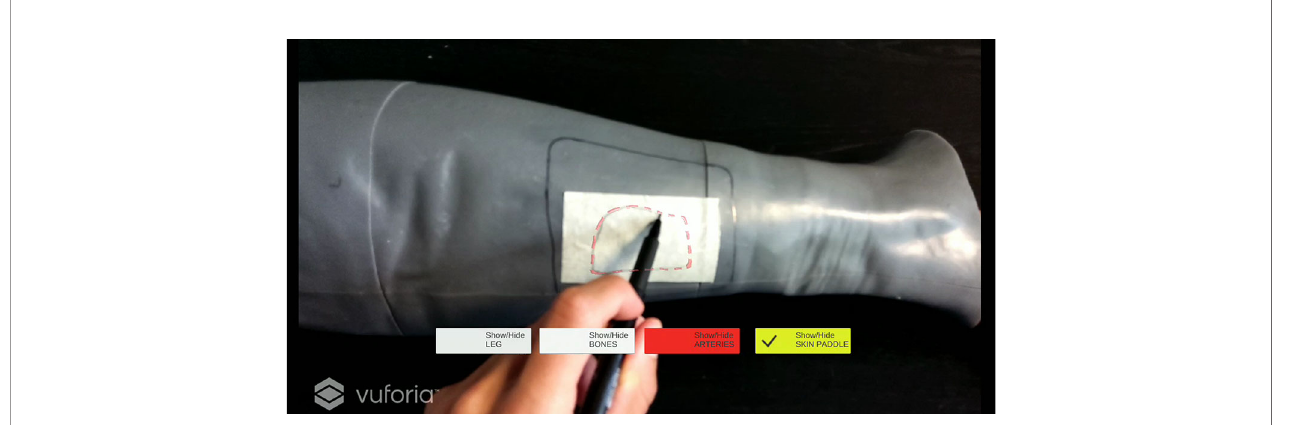
FIGURE 7 | Example of virtual skin paddle pro fi le displayed as a dashed line to avoid occlusion of the real scene by holograms.